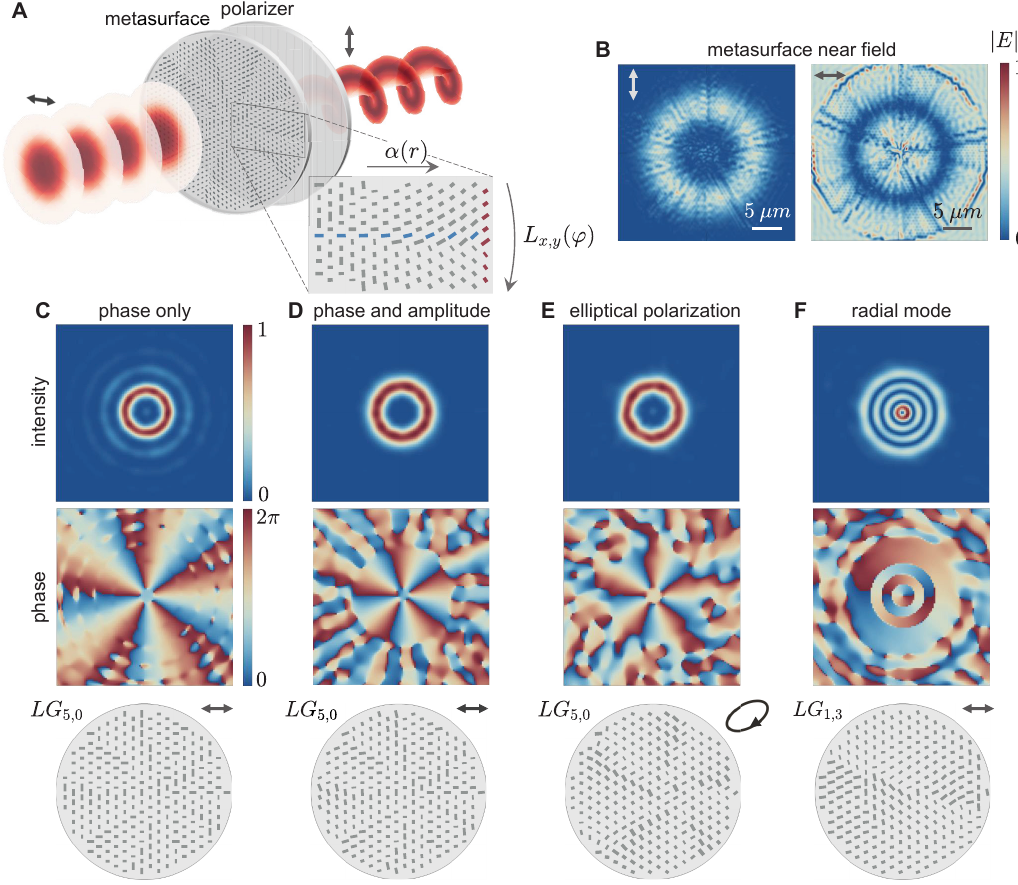
Figure 2: Pure vortex generation from a single metasurface. (A) Schematic of the system implementation for pure vortex generation. An input wave of known amplitude, phase, and polarization, here represented as a linearly polarized Gaussian beam, propagates through the metasurface and polarizer and exits as a pure vortex beam. The anglesofthenanopillarsalongtheradialdirections α ( r ) de fi netheamplitudemaskofthemetasurface,whiletheirrectangulardimensionsset theazimuthalphasepro fi le L x , y ( φ ) ofthebeam.(B)Near- fi eldintensitymapsobtainedby fi nite-differencetime-domain(FDTD)simulationsfor a metasurface generating an LG 5,0 mode. Only the vertically polarized component (left) is transmitted through the polarizer. (C – F) Far- fi eld intensity and phase distributions obtained by FDTD simulations for different structures: (C) a phase-only metasurface generating a superpositionofradialmodes;(D – F)phaseandamplitudemetasurfacesgeneratingpurevortexbeamsfordifferentinputandoutputstates.In allcases,thebottomrowshowsthecentralarea(10- μ mdiameter)ofthemetasurfacestructures,thetargetLaguerre – Gaussianbeam,andthe input polarization state (either linear or